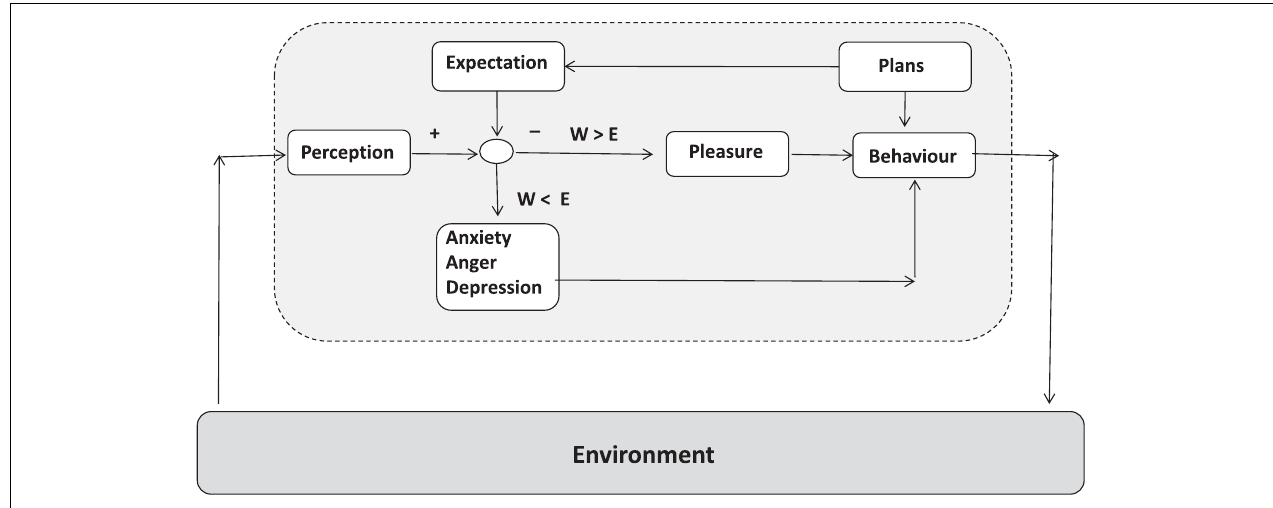
FIGURE 9 | The control loop model applied for explanation of the occurrence of pleasure and unpleasure (anxiety, aggression, sadness) by the congruence (or incongruence) of expectation compared with perception. Also, expected versus perceived outcome of planned action can induce emotions according to this circuit.